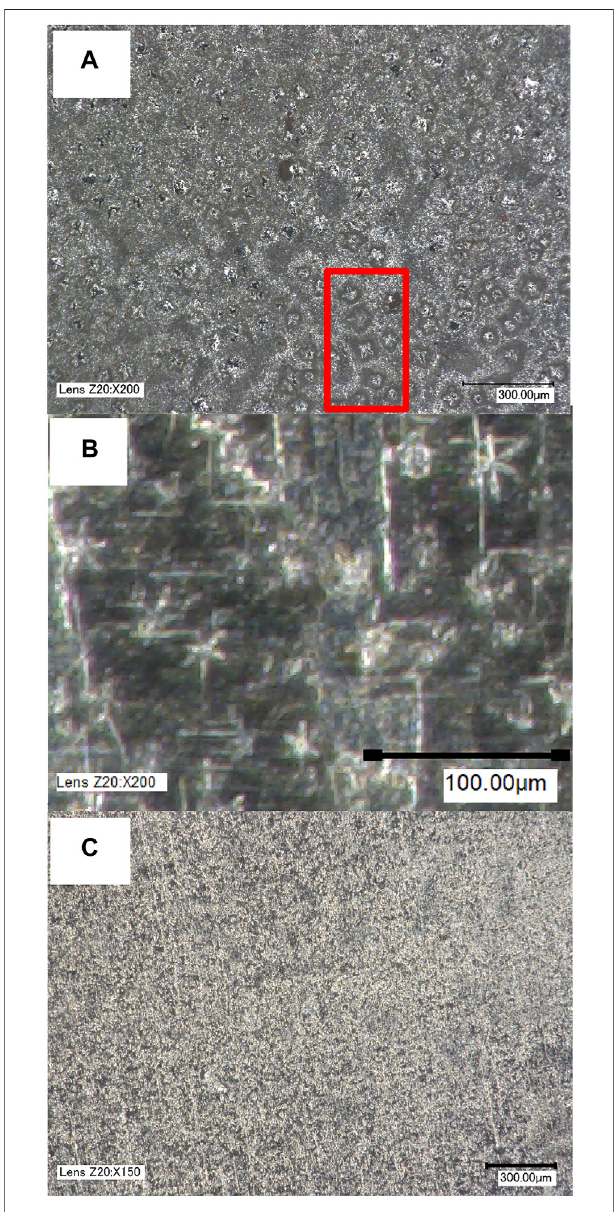
FIGURE 6 | Optical imaging ofsodium plated on copper after fi ve cycles ofplatingandstripping(endingonplatingat0.5 mA/0.25 mA h)at (A) 56 kPa, (B) 158 kPa and (C) 743 kPa pressure. A group of needle-like growths at 56 kPa are highlighted in red in (A) . At 158 kPa a higher zoom is used in (B)